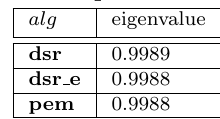
Table 4: Example 4.3. The table shows the eigenvalues of the models identified using the algorithms dsr , dsr e and pem .